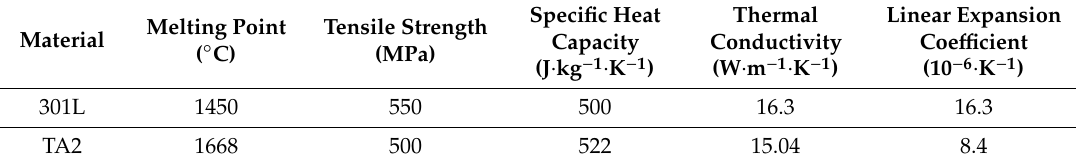
Table 3. The physical properties of 301L and TA2.